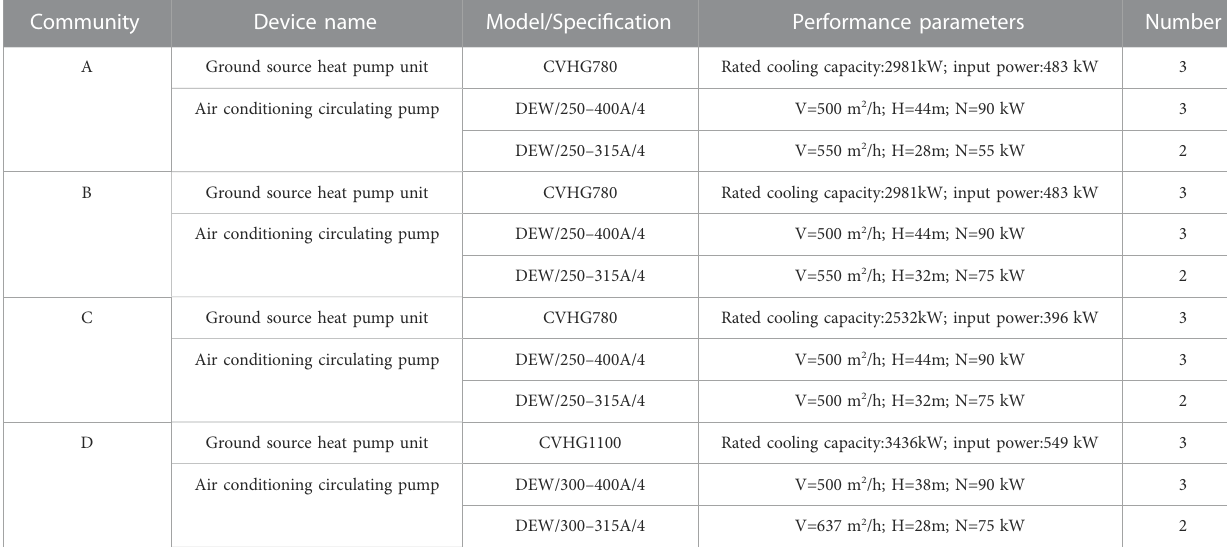
TABLE 1 Main equipment parameters of GWHP